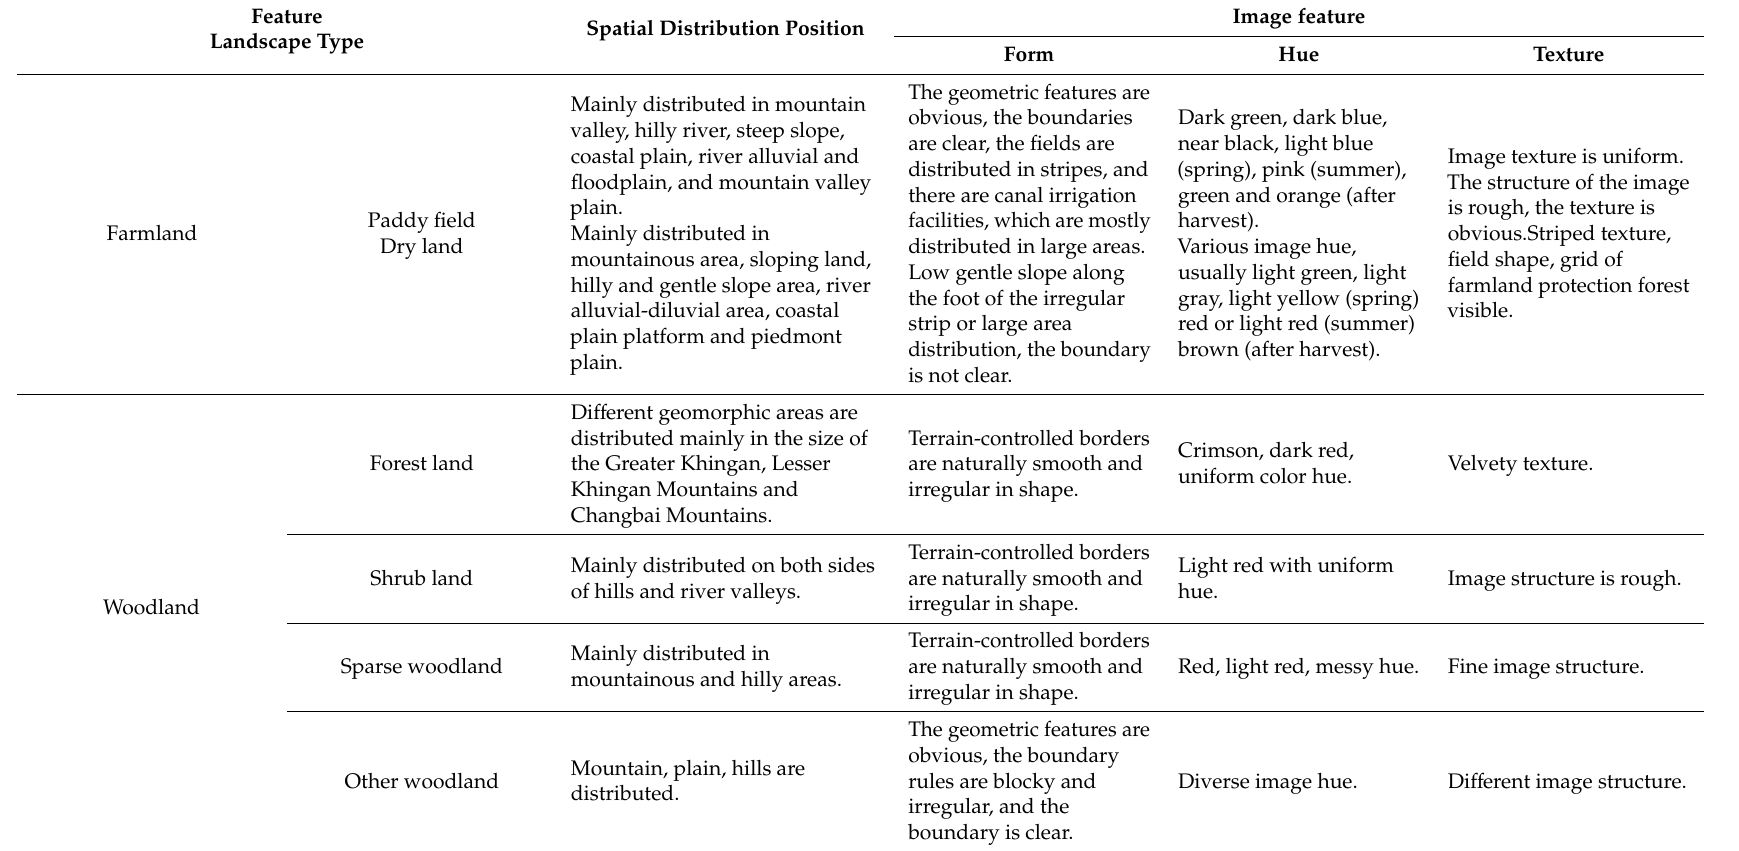
Table A1. Remote-sensing image (standard false color synthesis) interpretation